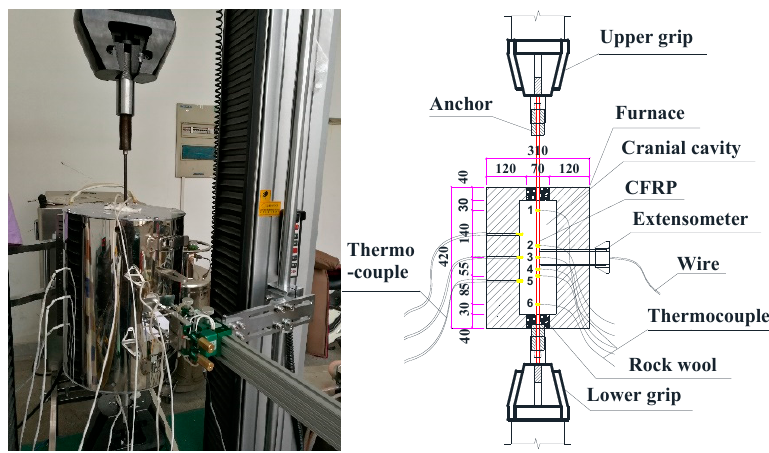
Figure 2. Test setup for CFRP tensile tests at elevated temperatures.